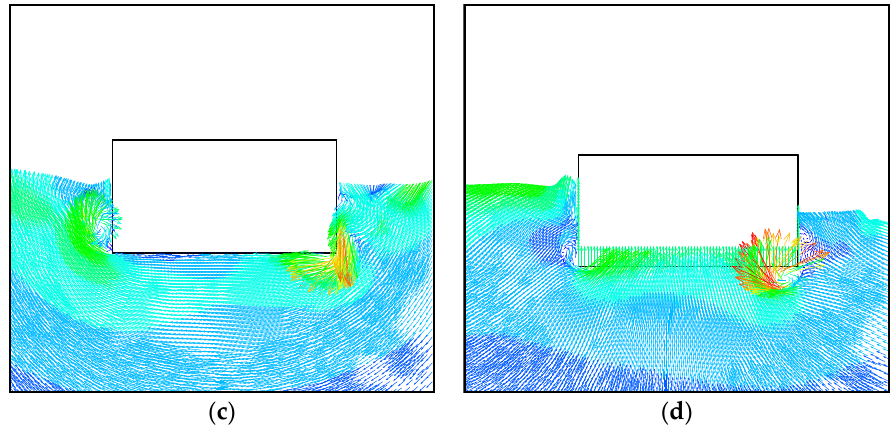
Figure 16. Flow fields around the buoy in a wave cycle ( W = 1:2, H = 0.1 m, T = 1.75 s): ( a ) t = T/4; ( b ) t = 2T/4; ( c ) t = 3T/4; ( d ) t = 4T/4.